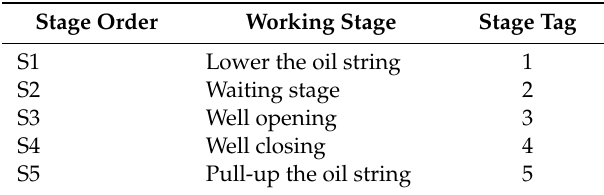
Figure 6. Well-testing workflow from data acquisition to data playback. Figure 6. Well ‐ testing workflow from data acquisition to data playback. Figure 6. Well ‐ testing workflow from data acquisition to data playback. Table 4. Working stages and the corresponding stage tags Table 4. Working stages and the corresponding stage tags Table 2. Working stages and the corresponding stage